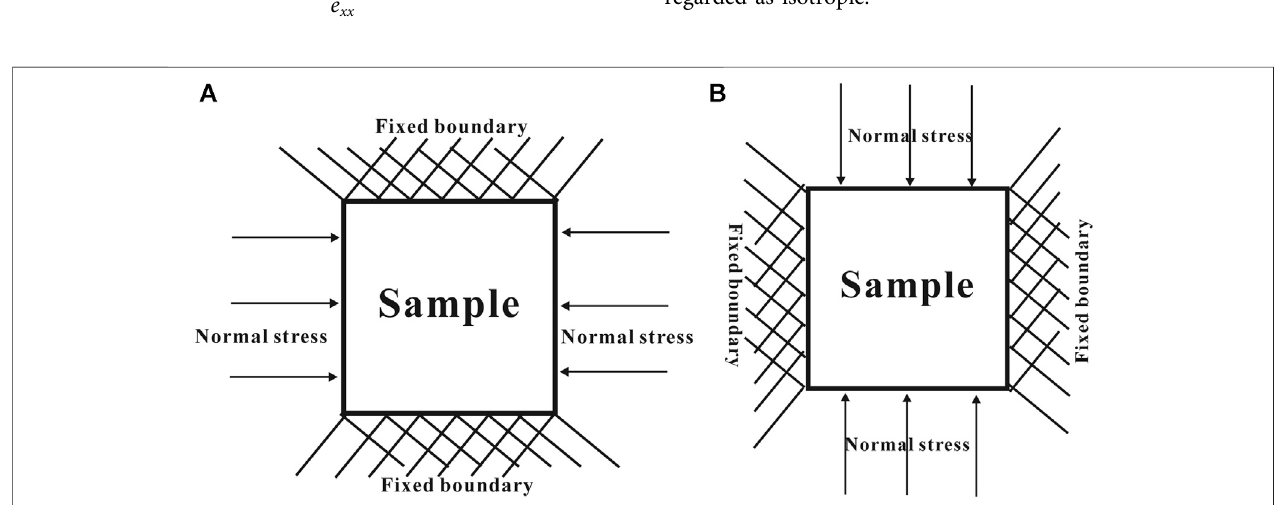
FIGURE A-1 | The test model to verify the isotropy of the sample.